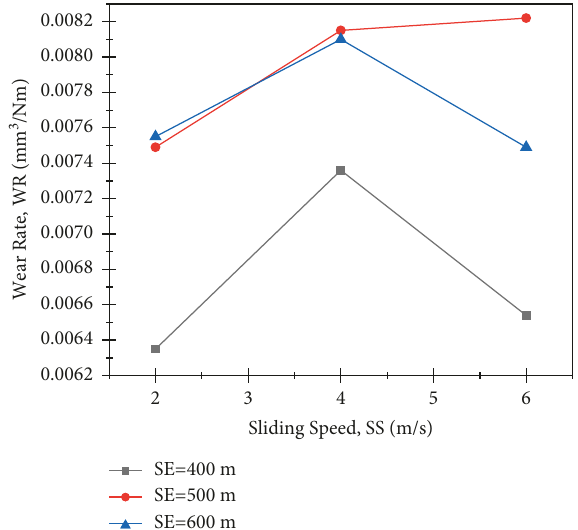
Figure 4: Interaction between SS and SE levels at LD � 40N.